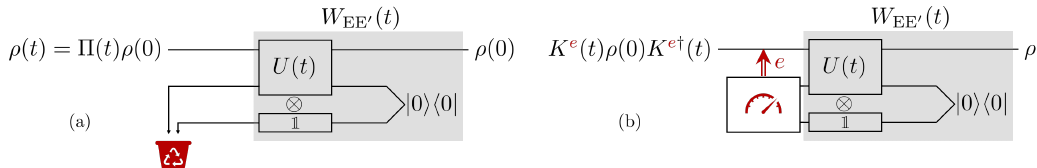
Figure 2: Quantum circuits corresponding to the operator sum (10) and its individual terms. (a) Reduced evolution: Evolved state is averaged over all possible outcomes e of measurements on the purified environment indicated by the trash can. (b) Condi- tional evolution: Classical communication of a specific outcome e of a measurement results in a state update described by a single Kraus